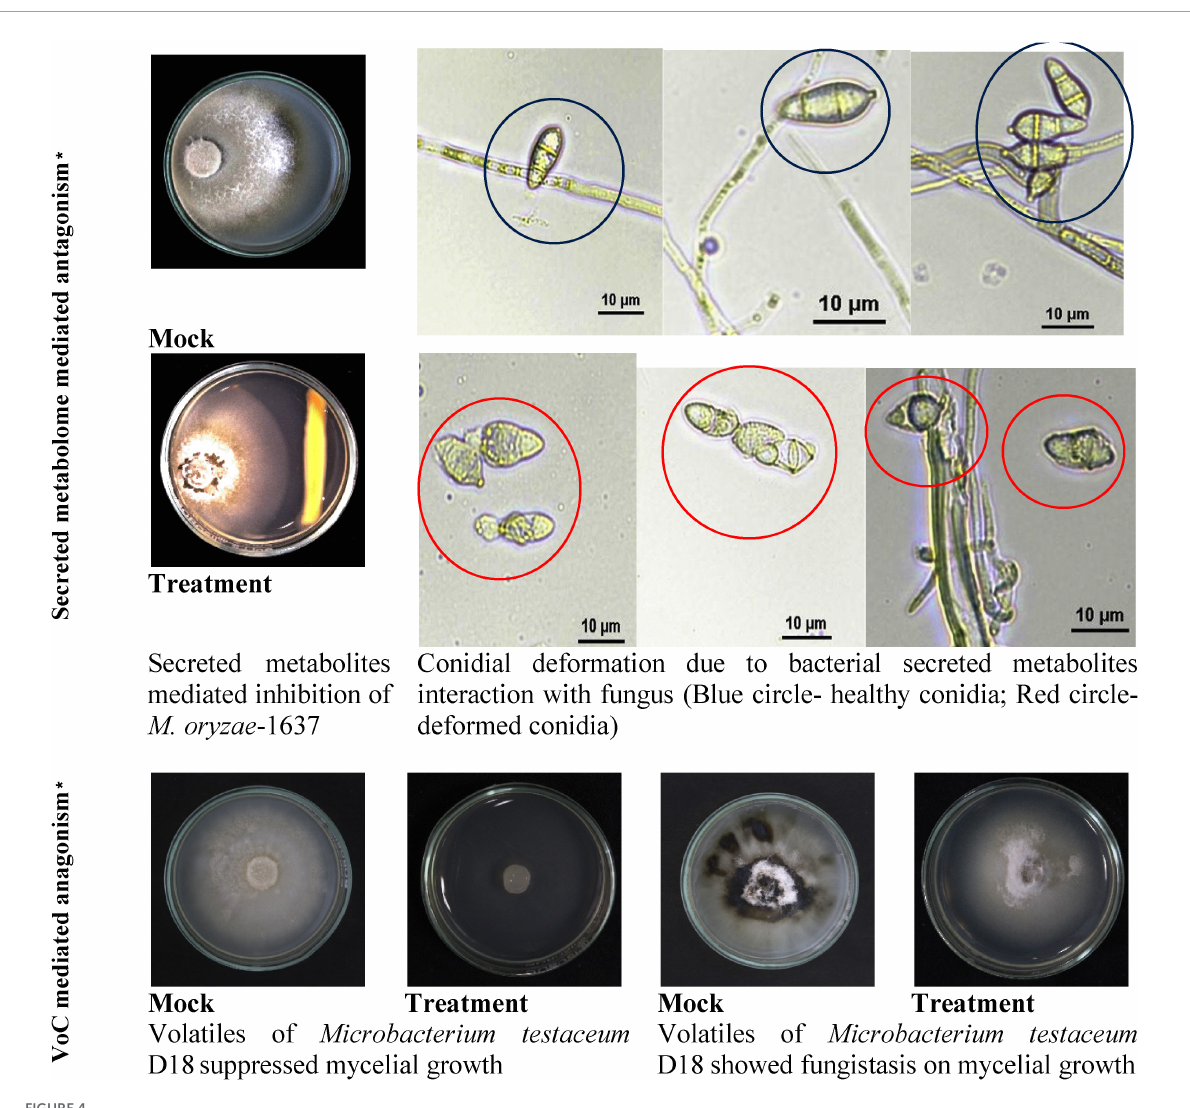
FIGURE4 Secreted and volatile metabolite mediated antagonism of M. testaceum D18 on M. oryzae -1637. *% reduction in mycelial growth of Magnaporthe oryzae was observed over mock in both secreted metabolite as well as volatile mediated dual culture assays. In addition to this deformation in conidial morphology was observed in the secreted metabolite-mediated